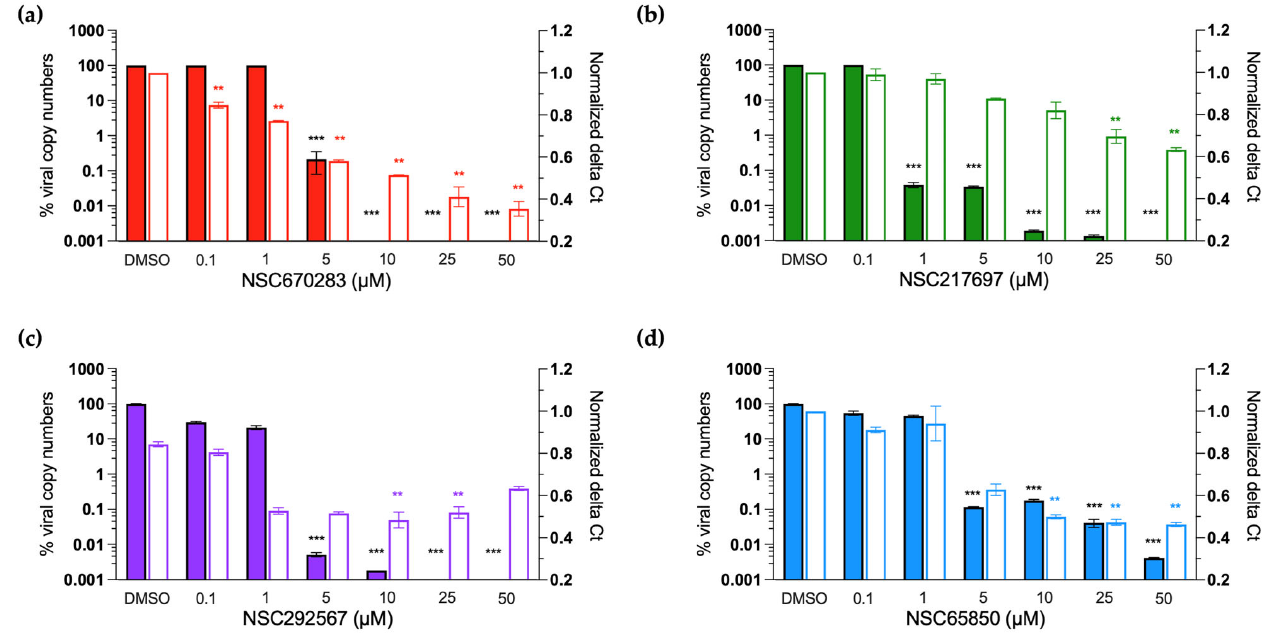
Figure 4. Percent viral copy numbers and the delta Ct values of negative-stranded RNA of FMDV- infected BHK-21 cells with or without compound treatments. The infected cells were treated with serial concentrations of the selected compounds to demonstrate the dose-dependent effect. The selected compounds included NSC670283 ( a ; red), NSC217697 ( b ; green), NSC292567 ( c ; purple), and NSC65850 ( d ; blue). The bar graphs were plotted between differential drug concentrations ( X -axis), % viral copy number (left Y -axis), and the normalized delta Ct values of negative-stranded RNA (right Y -axis). The solid-color bars represent % viral copy numbers and the empty bars are the normalized delta Cts. The asterisks denote the significance levels with ** meaning a p value of 0.01 and *** a p value of 0.001.